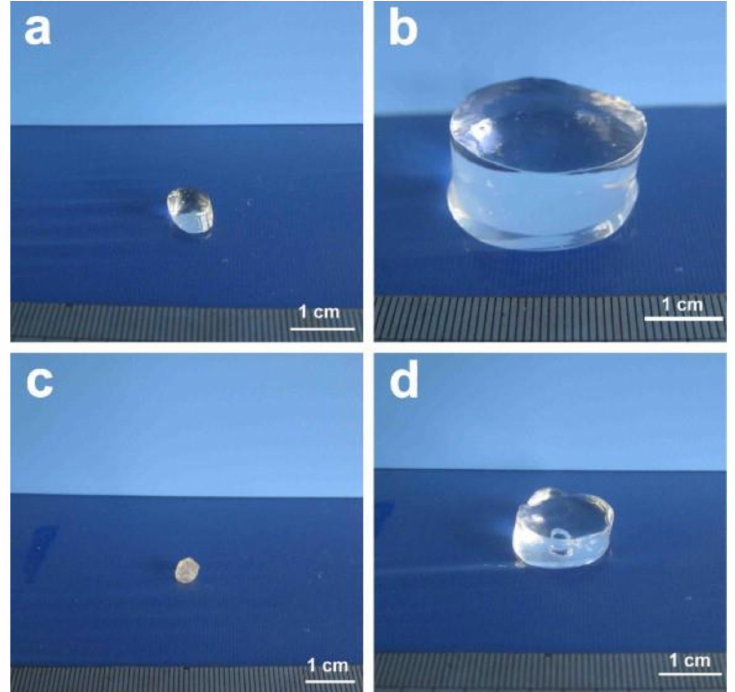
Figure 4. Photographs of superabsorbent cellulose/carboxymethylcellulose (CMC) hydrogels: ( a ) original hydrogel, ( b ) swollen hydrogel, ( c ) dried hydrogel, and ( d ) hydrogel after swelling in NaCl solution for a week. Reprinted from ref. [118] © 2021 with permission from